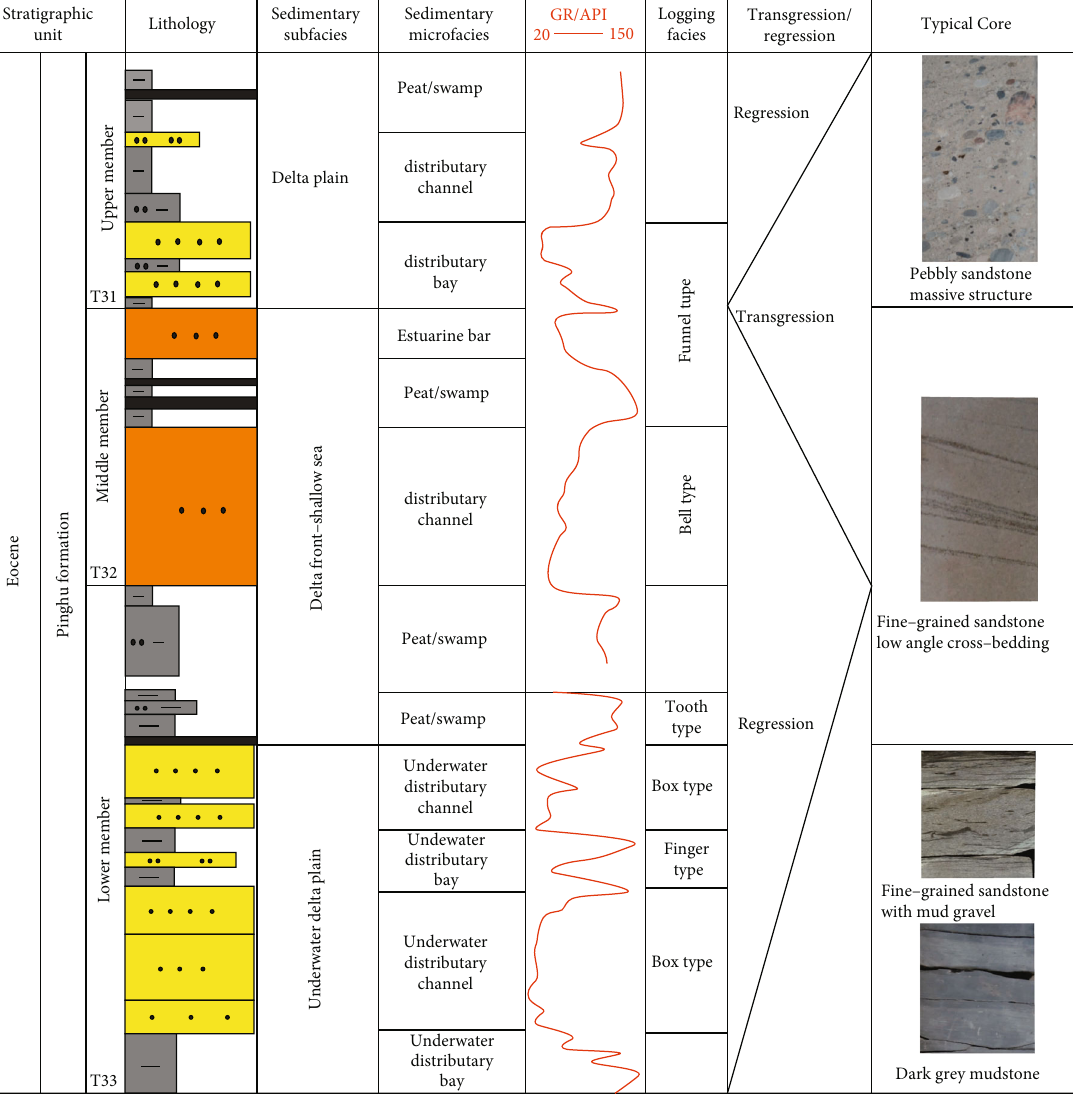
Figure 7: Sedimentary characteristics and evolution of the Pinghu